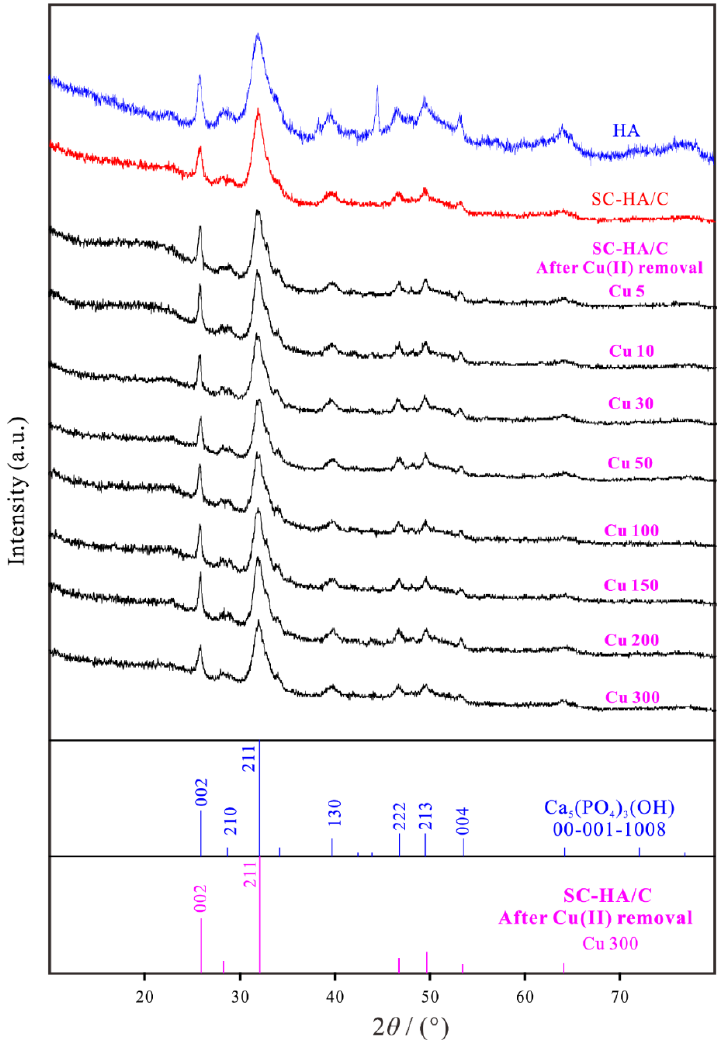
Figure 1. XRD spectra of the SC–HA/C composite before and after Cu (II) removal.